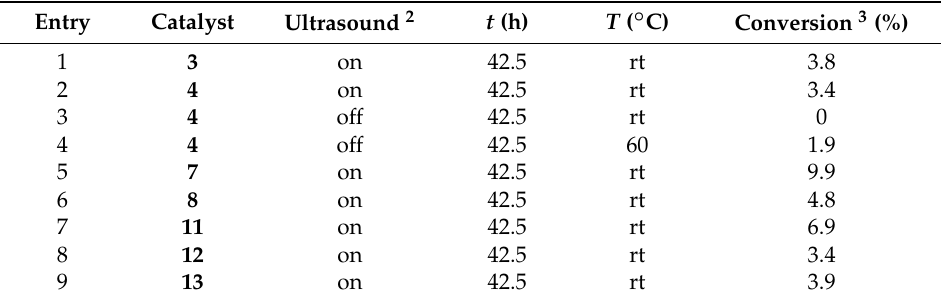
Table 1. “Click” reactions between benzyl azide ( 14 ) and phenylacetylene ( 15 ) using ultrasound in the presence of mechanophoric catalysts. 1